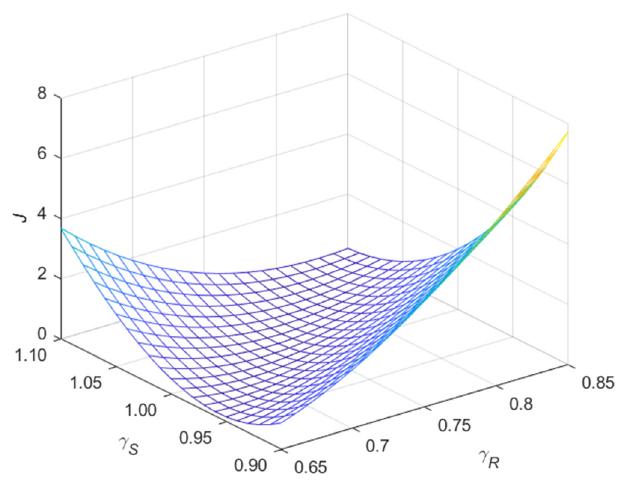
Figure 7. Cost in load & resistance factor space